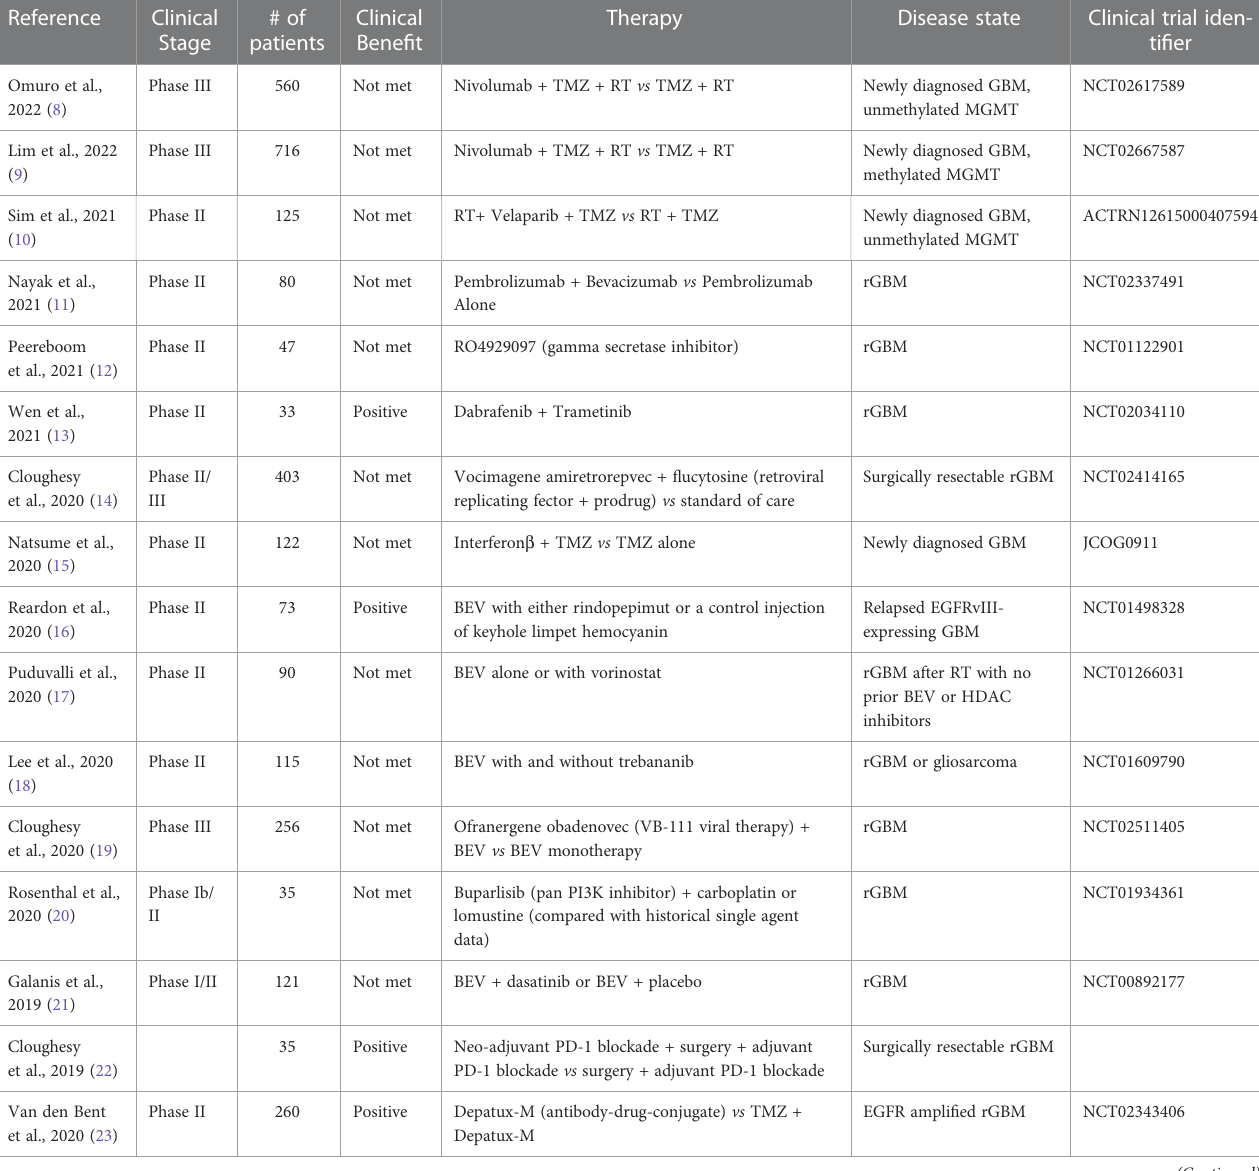
TABLE 1 Summary of Phase II-III Randomized Clinical Trials for Drug Combinations in GBM and their outcome.